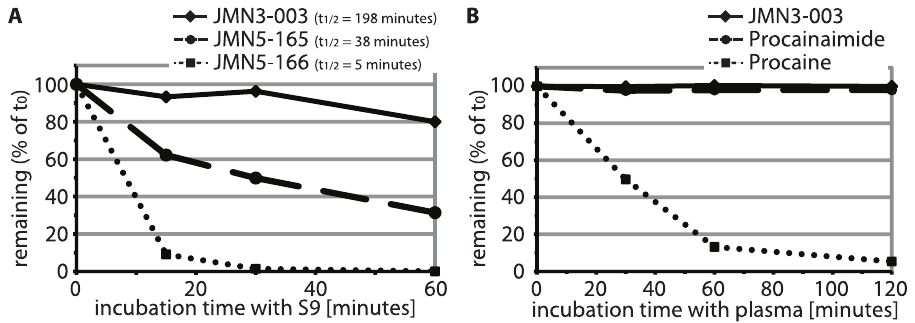
Figure 3. The JMN3-003 scaffold is metabolically stable invitro . A ) Incubation of the article with human liver S9 fractions for up to 60 minutes, followed by LC-MS/MS analysis of the material remaining. Two analogs of JMN3-003, JMN5-165 and JMN5-166 (figure S1), showed little stability and are included for comparison. Values represent averages of 2 replicates, calculated half-lives (t 1/2 ) are given in the figure captures. B ) Incubation of JMN3-003 for up to 120 minutes with human plasma derived from mixed, healthy donors, followed by LC-MS/MS quantification of the material remaining. Unstable procaine and stable procainamide were examined equally for comparison. Values represent averages of three experiments 6